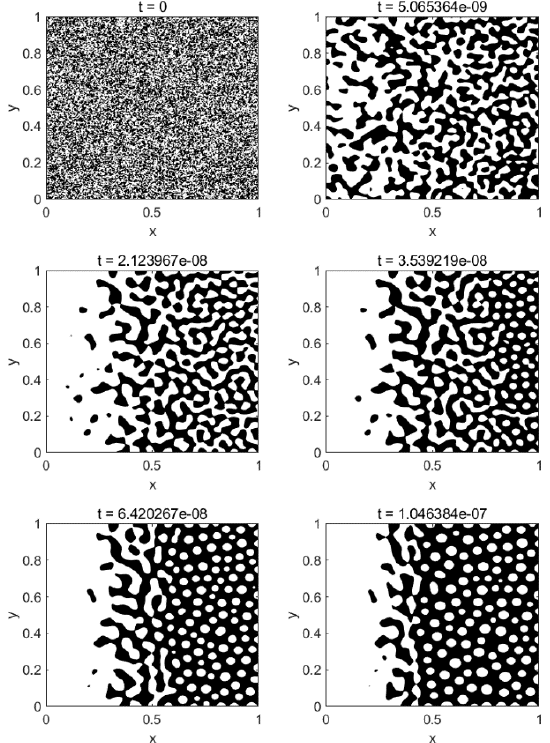
Figure 3. Patterns formed during the phase separation phenomena for the case where D = 10 5 , c o* = 0.3 and T 1* = 0.34 at x * = 0 and T 2* = 0.30 at x * = 1. The asterisks were left out of the variables x , y , and t in the figure.